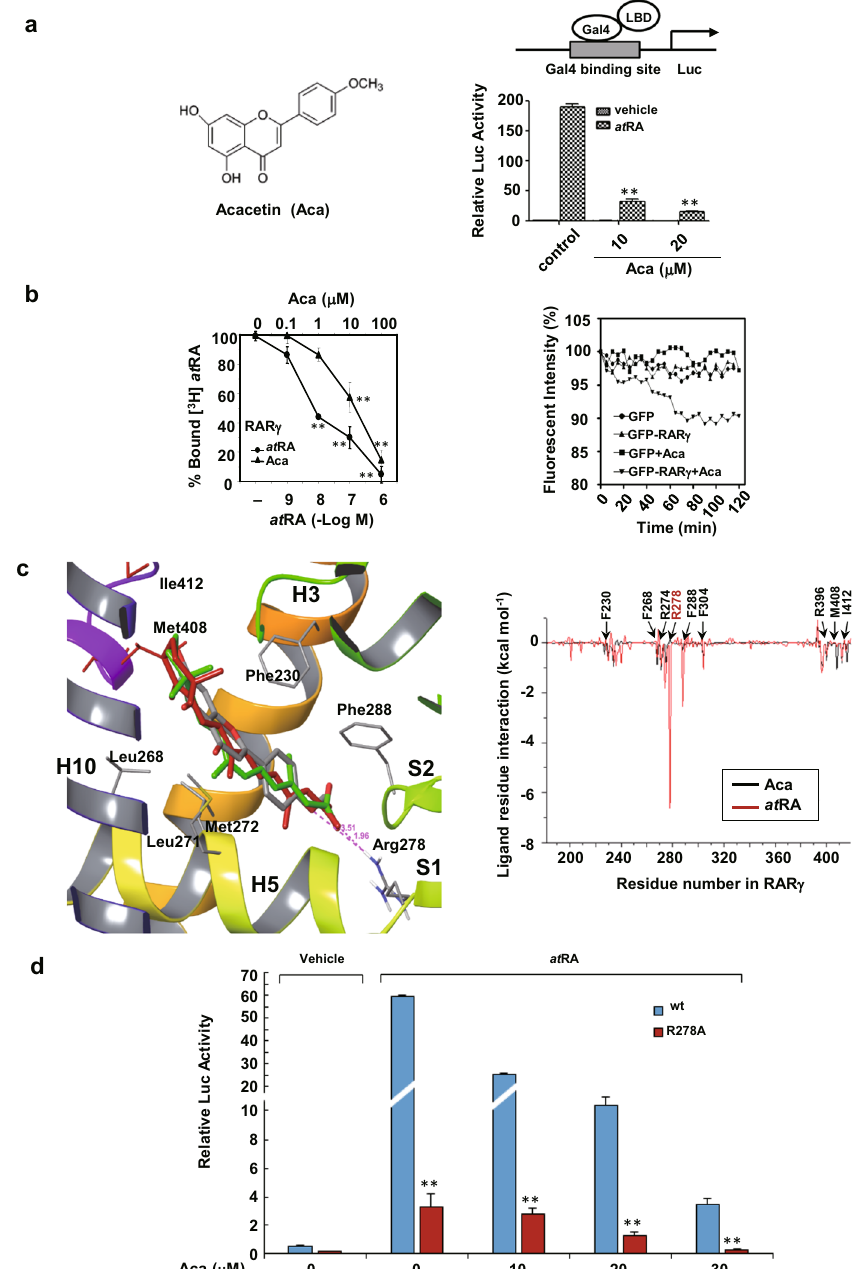
Figure 1. Acacetin antagonizes at RA-induced RAR γ transcription and binds to RAR γ . ( a ) The chemical structure of acacetin is indicated (left). HEK293T cells were co-transfected with pG5-luciferase reporter and pBind-RAR γ LBD constructs. The cells were treated with vehicle or acacetin for 12 h in the presence or absence of 10 − 7 M at RA and then assayed for luciferase and β -galactosidase activities (right). ( b ) The purified RAR γ LBD was incubated with [ 3 H] at RA in the presence of either at RA or acacetin at an increasing concentrations. The capabilities of unlabeled at RA and acacetin to displace the radio-labeled [ 3 H] at RA were evaluated by liquid scintillation counting after 12 h treatment (left). For cell-based assays, HepG2 cells transfected with GFP or GFP-RAR γ were exposed to 10 μ M acacetin or vehicle for 2 h. The images of live cells incubated at 37 °C were taken every 5 min for assaying the fluorescence intensity (right). ( c ) Structural comparison of acacetin (gray), 9- cis -RA (green), and at RA (red) on their interactions with the RAR γ LBD (left). MM-PB/SA was used to calculate the binding free energies in each residue of amino acids 180–450 in the RAR γ LBD that was docked with at RA and acacetin (right). ( d ) HEK293T cells were transfected with Gal4-RAR γ /wt or Gal4-RAR γ /R278A plasmids and treated with at RA (10 − 7 M) in the presence or absence of acacetin at different concentrations. For ( a ), ( b ) and ( d ), the data represent mean ± S.D. of relative luciferase activity generated in triplicate transfections in at least three independent experiments. * p < 0.05 and ** p < 0.01 in ( a ) (acacetin + at RA vs at RA), in ( b ) ( vs vehicle control) and in ( d ) (R278 vs